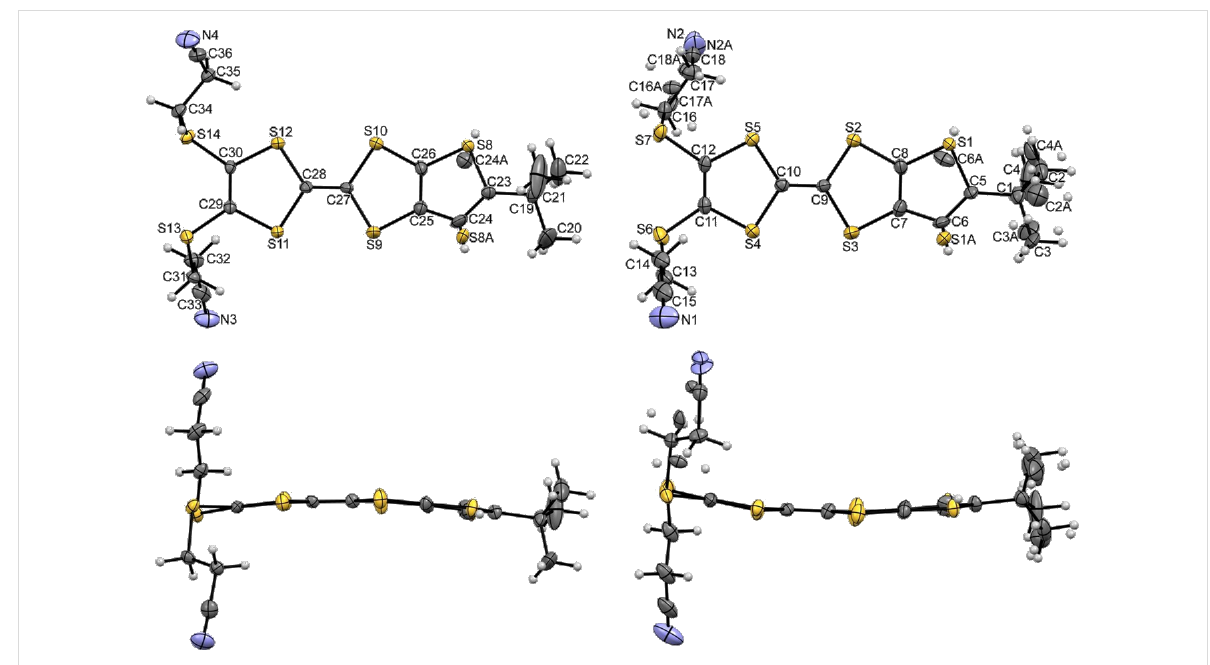
Figure 5: ORTEP views and atomic numbering scheme of α -tbtdt ( 1 ) with thermal ellipsoids at 50% probability level.